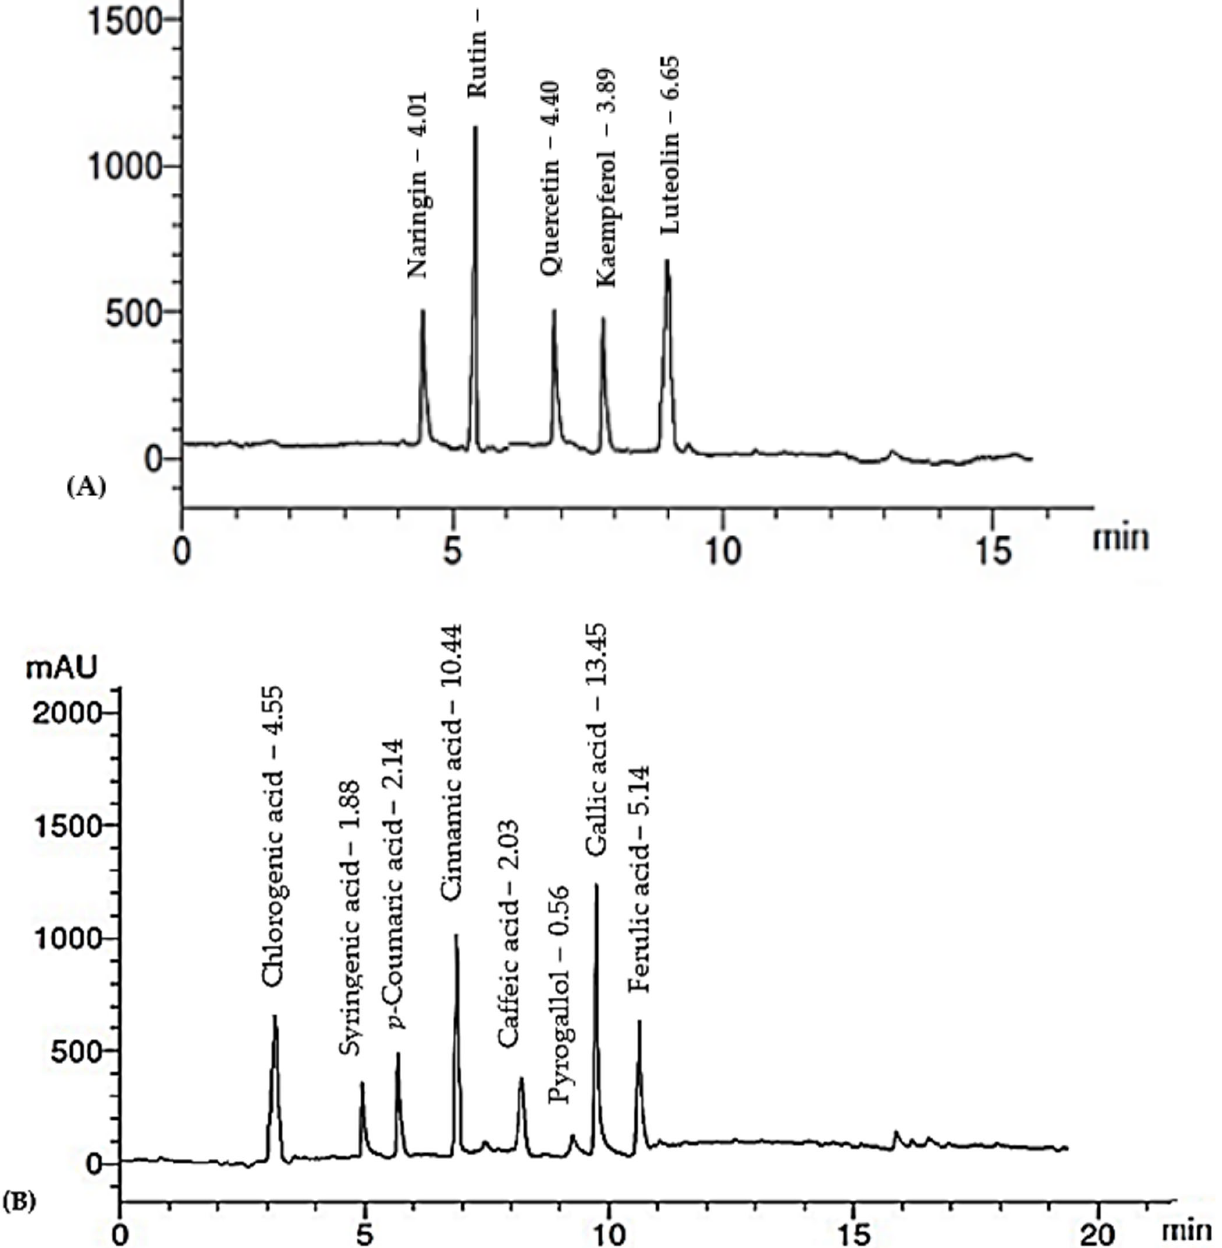
Figure 2. HPLC chromatogram of identi fi ed fl avonoids ( A ) and phenolic acids ( B ) in the RCFE.